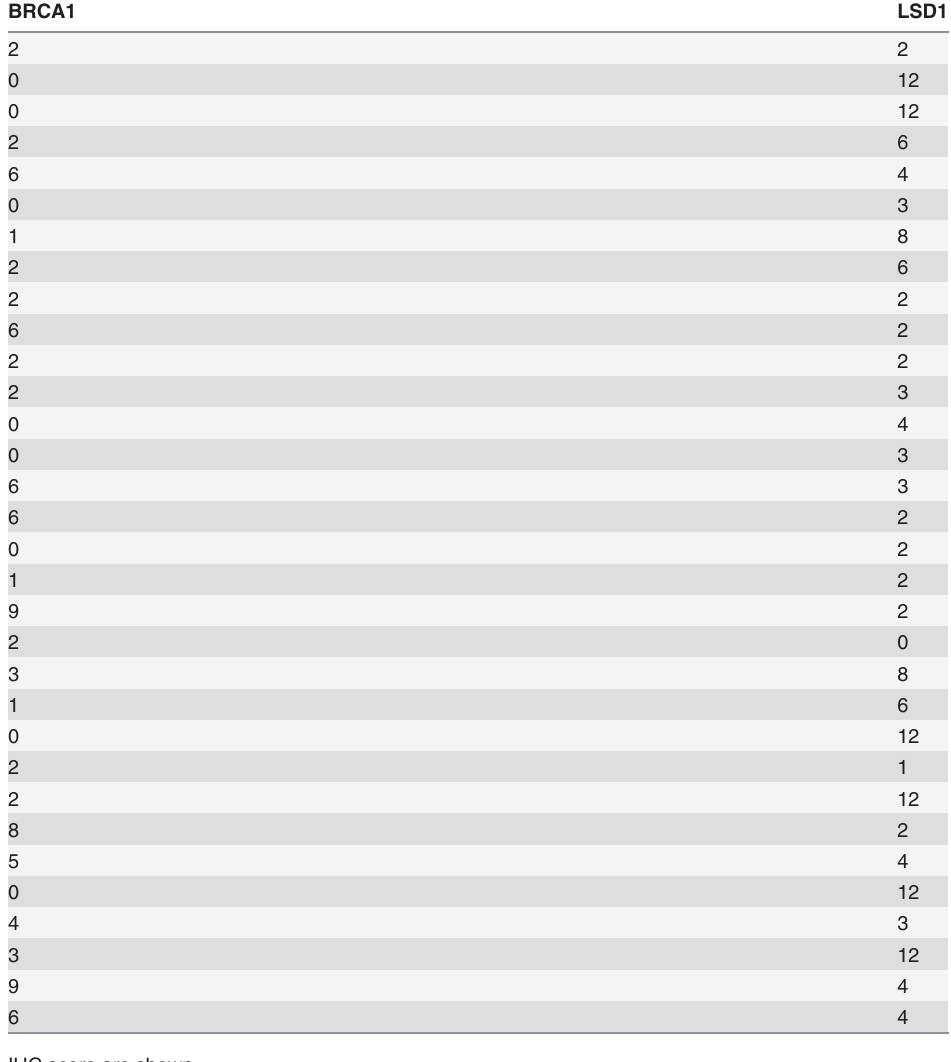
Table 4. Protein expression of BRCA1 and LSD1 in triple negative breast cancer.